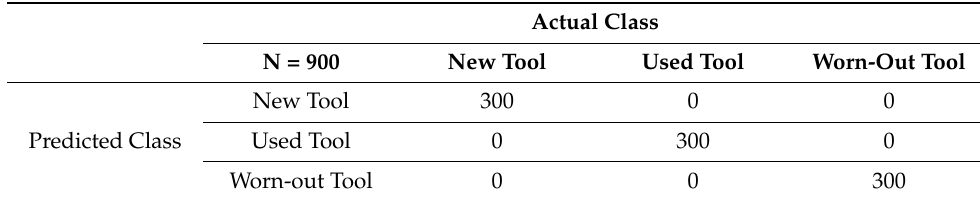
Table 2. Confusion matrix for